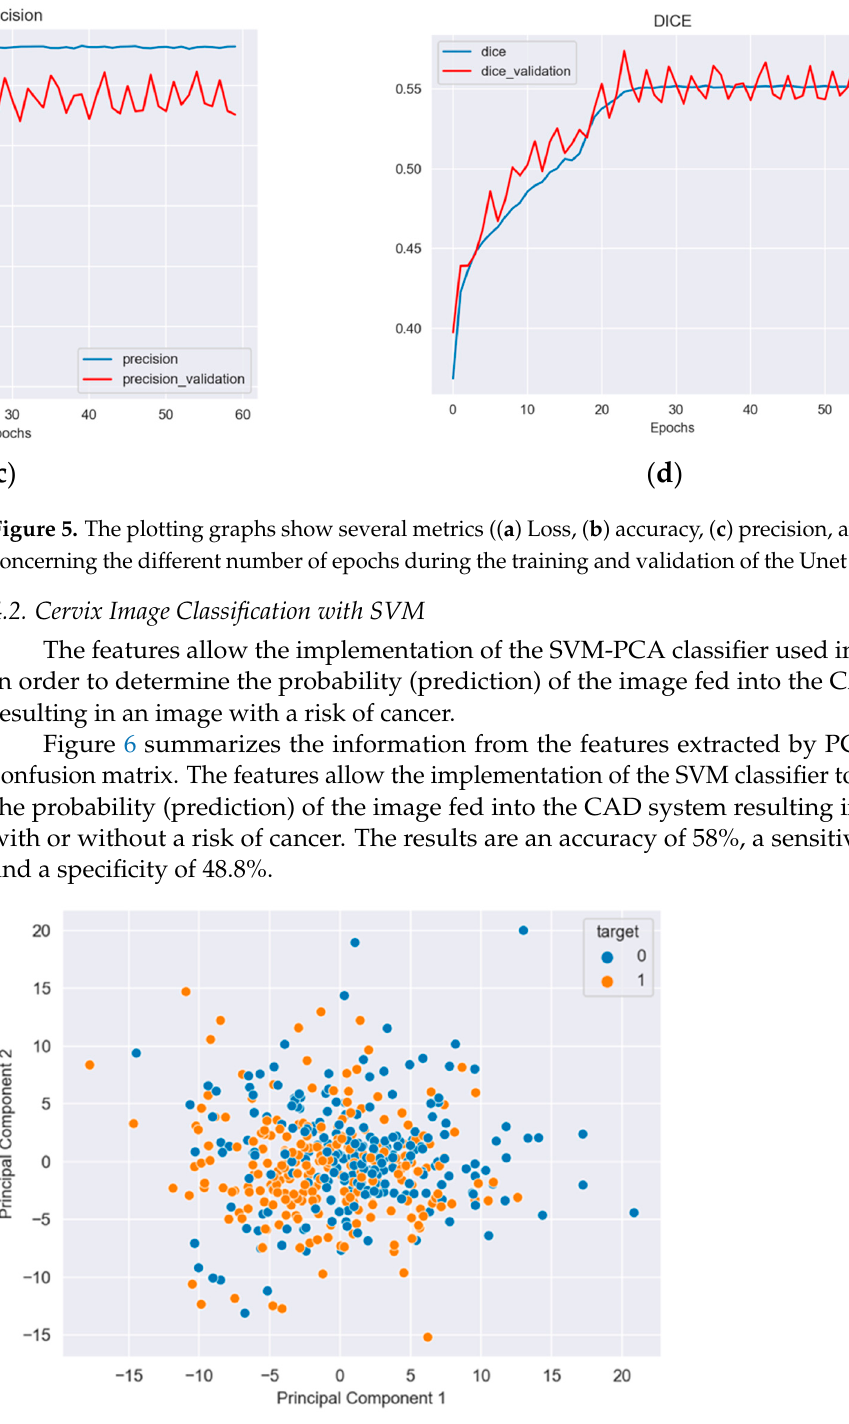
Figure 6. The PCA analysis shows the dispersion and independence between two 0 and 1 classes.